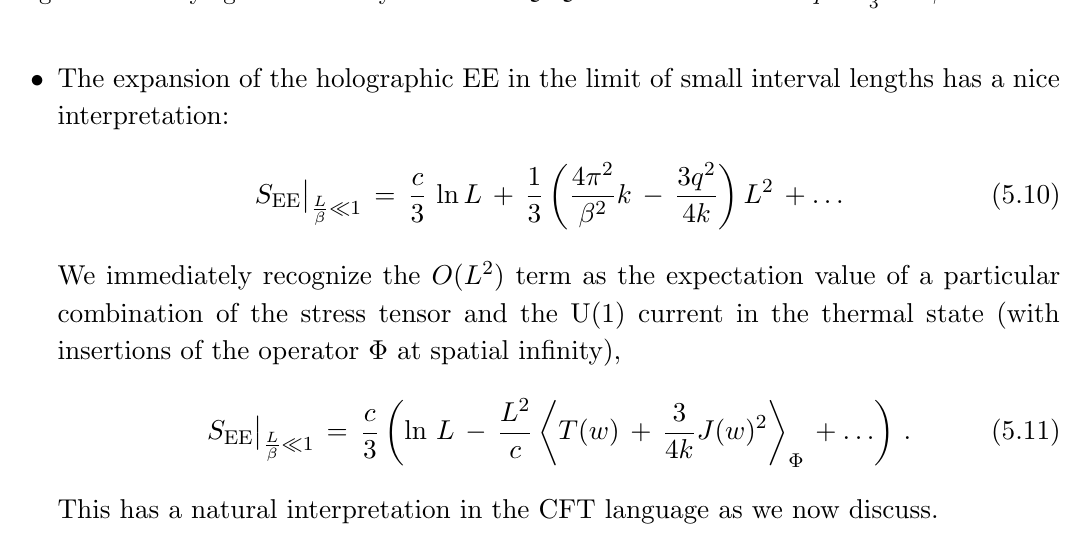
Figure 4 . The product backgrounds satisfying the holonomy conditions.